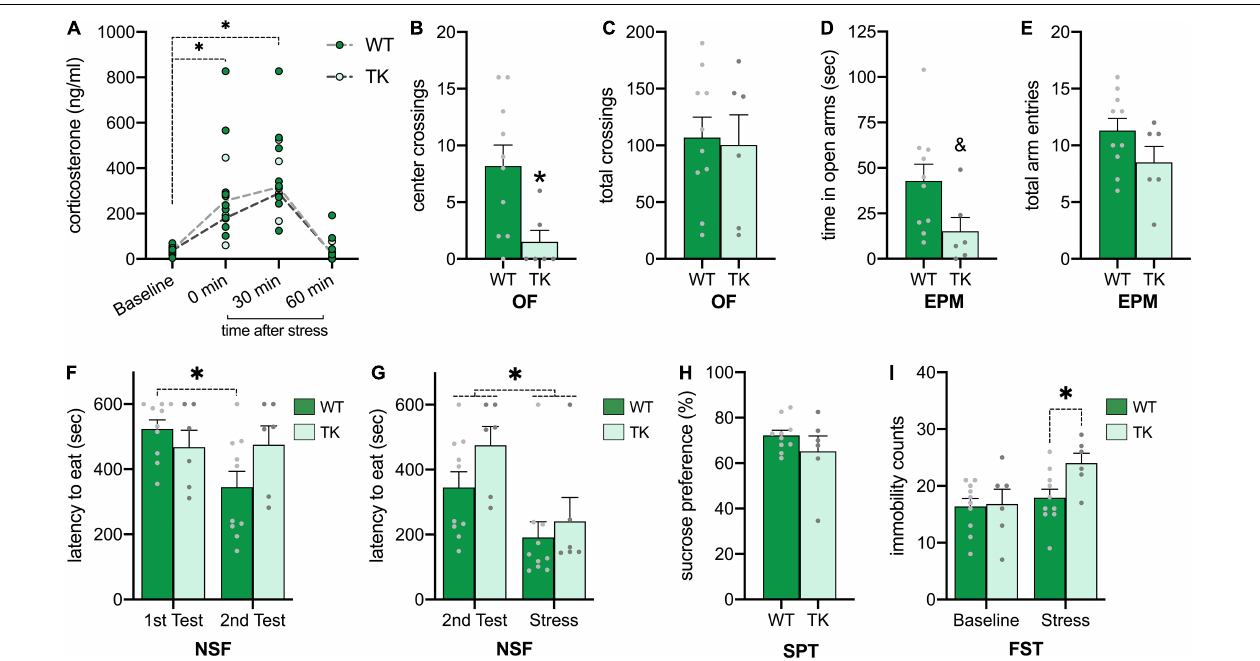
FIGURE 3 | Inhibition of neurogenesis from adolescence increases stress-associated anxiodepressive behaviors. (A) Corticosterone is increased similarly following acute restraint (B,C) Transgenic (TK) rats had increased anxiety-like behavior on the open field (B) , despite similar locomotion (C) . (D,E) TK rats had a tendency toward decreased exploration in open arms (D) but similar overall locomotion in the elevated plus-maze (E) . (F,G) TK rats fail to habituate to the novelty-suppressed feeding arena at baseline (F) , but acute restraint hastens eating in all rats (G) . (H) All rats show similar sucrose preference. (I) All rats showed similar immobility in the forced swim test, but TK rats had more immobility following acute restraint. * p < α compared to baseline or wildtype (WT). & p < 0.10 compared to WT. All bars represent S.E.M. and dots represent individual rat